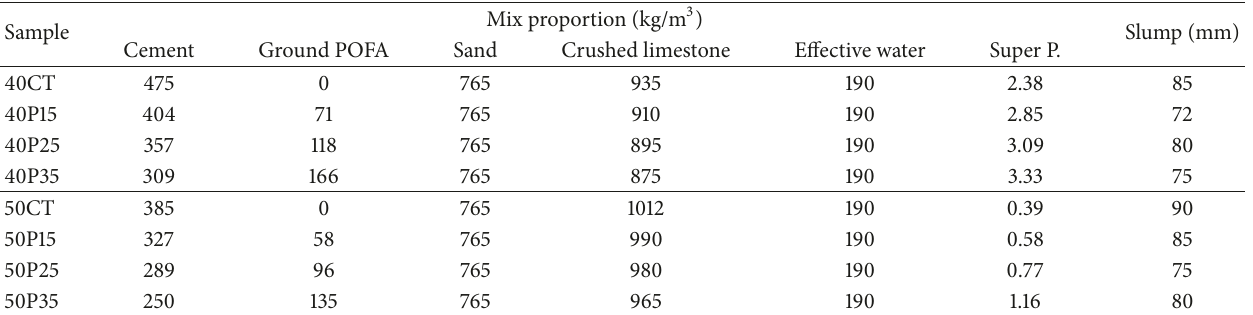
Table 3: Mixture proportions of the types of